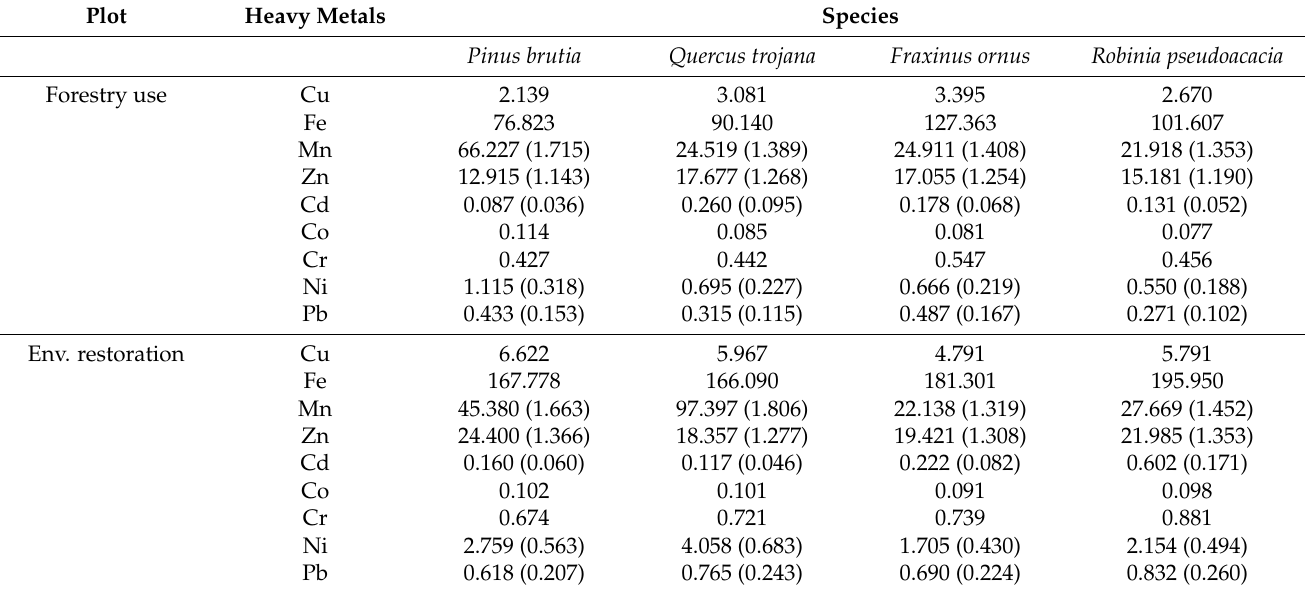
Table 2. Heavy metal concentration in forestry use landscape and in the environmental area (ppm) 1